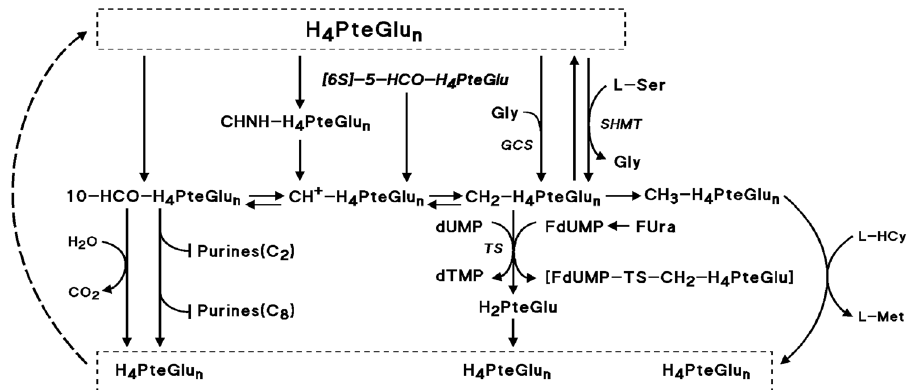
Figure 1. Selected Pathways of folates. Folates. H 2 PteGlu: 7,8-dihydrofolate; H 4 PteGlu: 5,6,7,8-tetrahydrofolate;